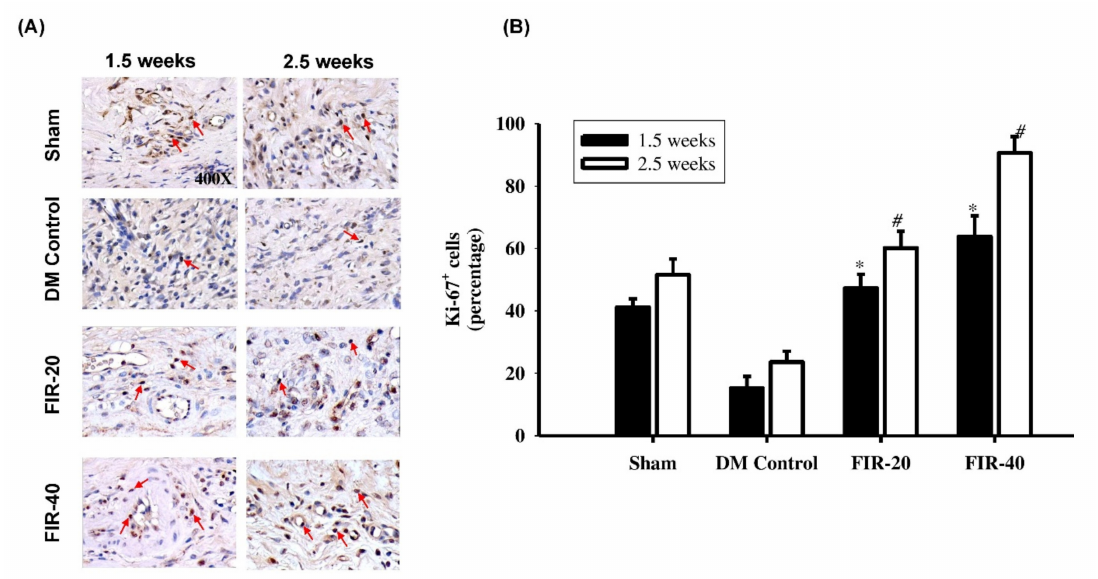
Figure 5. Far-infrared radiation (FIR) treatment in facilitating cell proliferation. ( A ) Analyze cell expansion based on the Ki-67 expression level (red arrow) at the wound edge, which is determined by performing HRP-DAB IHC staining. Expansion increment in Ki-67 expression, particularly in fibroblasts in the basal epidermal and subcutaneous layers, in the FIR-20- and FIR-40-treated diabetic rat groups at the early (1.5 weeks) and the late (2.5 weeks) stage after treatment compared with the DM control group ( p < 0.001). ( B ) Summary of Ki-67+ cells in periwound edges after FIR-treatment. Furthermore, the rats in the FIR-40 group exhibited a marked increase in Ki-67 expression in the wound edge compared to that in the FIR-20 group. * p < 0.05 (at 1.5 weeks); # p < 0.05 (at 2.5 weeks). Magnification, 400 ×